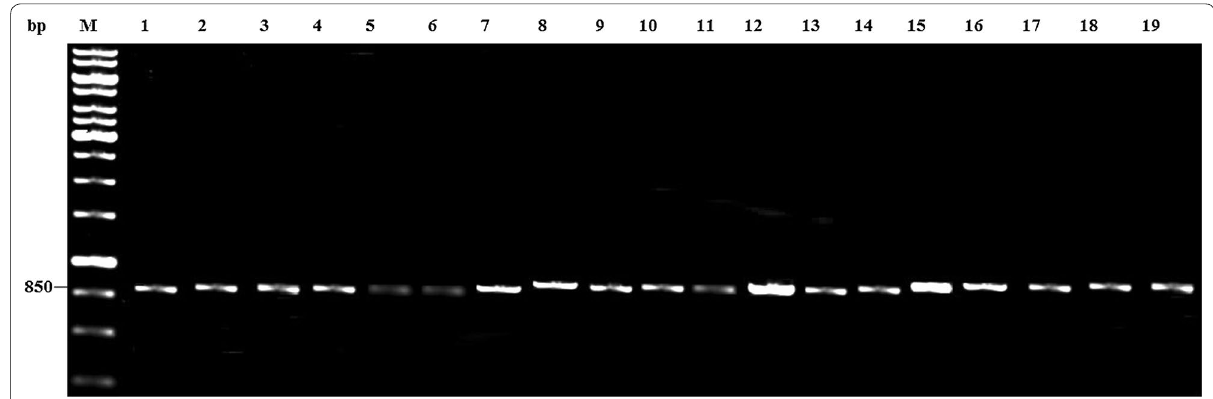
Fig. 2 Agarose gel photograph amplified DNA sequences of 850 bp. Lane M Lane 2— Termitomyces aurantiacus ; Lane 3— Termitomyces aurantiacus ; Lane 4— Termitomyces aurantiacus ; Lane 5— Tricholoma matsutake ;